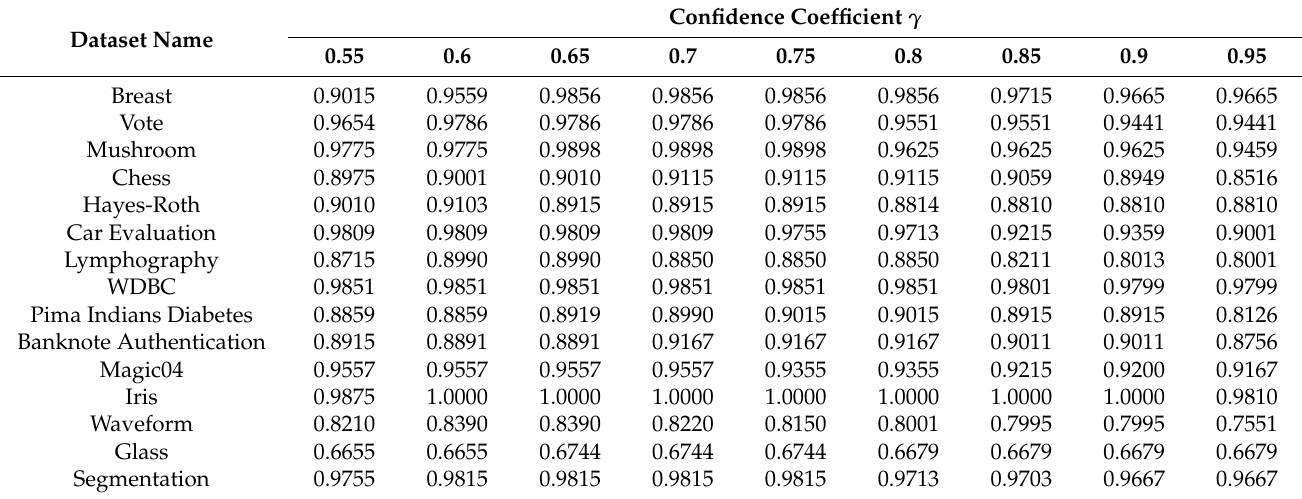
Table 7. Accuracy Statistics